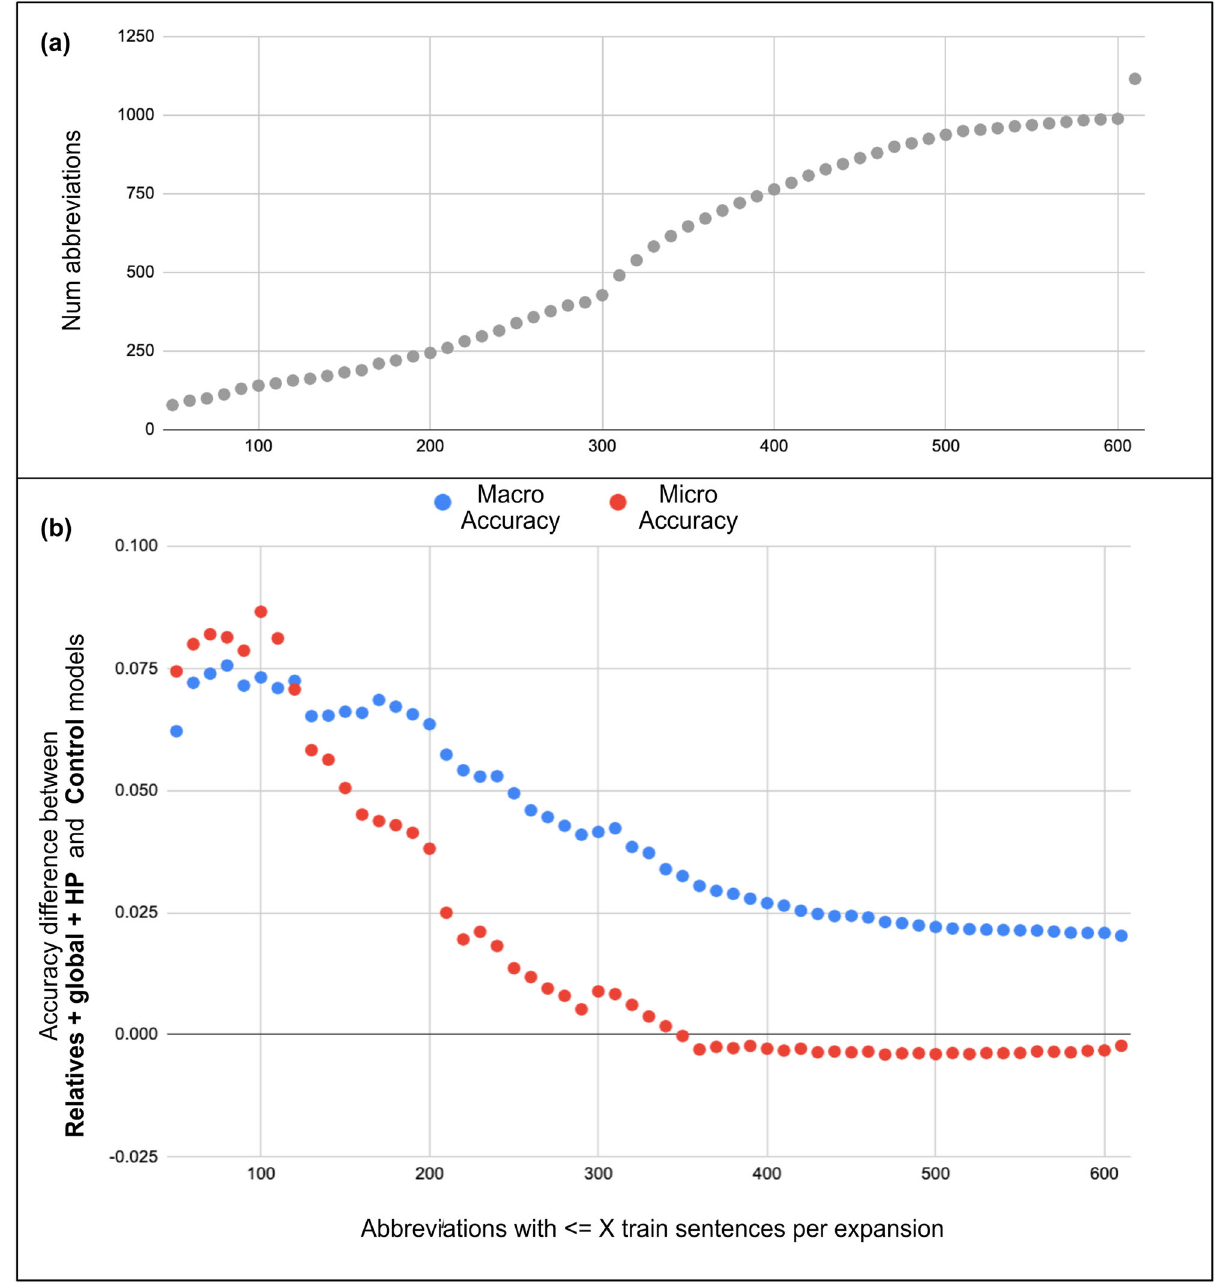
Fig. 4 Performance difference between Relatives + global + HP and control models on i2b2 test with an increasing number of training samples per abbreviation. The x -axis marks abbreviations with an average less than or equal to X training sentences per expansion. a Number of abbreviations that have an average of less than X training sentences per expansion. b Difference in macro (blue) and micro (red) accuracy for these abbreviations between our best and control